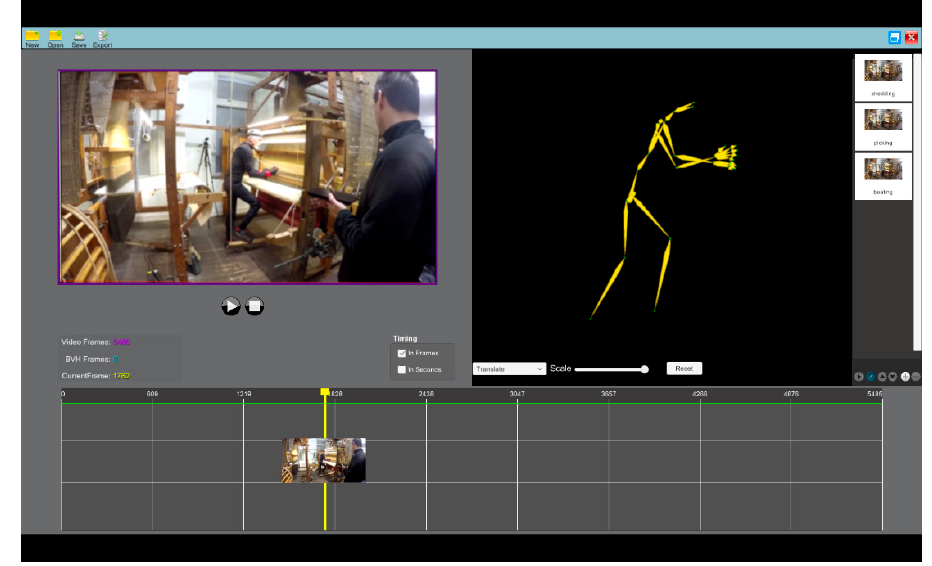
Figure 8. AnimIO version 2.0.